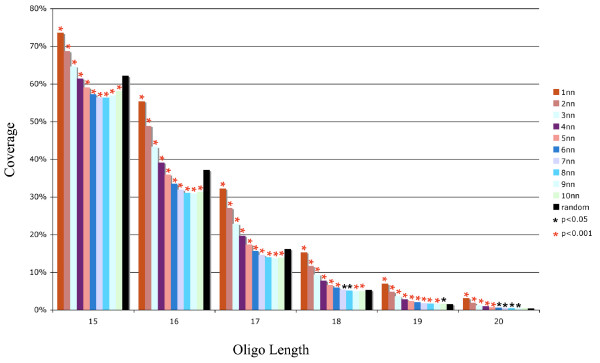
The density of the human genome in sequence space. For every randomly generated n-mer that was detected in the human genome, we generated all single basepair variants (3n variants for each n-mer) and tested them to see if they were also represented in the human genome (1nn). We also generated 3n of the 2 bp variants (2nn), 3n of the 3 bp variants, and so on up to variants that differed in 10 bp from the original human n-mer. The sequences that are only a few SNPs away from the original human n-mer are significantly more likely to be in the human genome compared to a random n-mer (black bars, "random"). This shows that the human genome is relatively compact in sequence space. The standard error for all points is < 0.003.